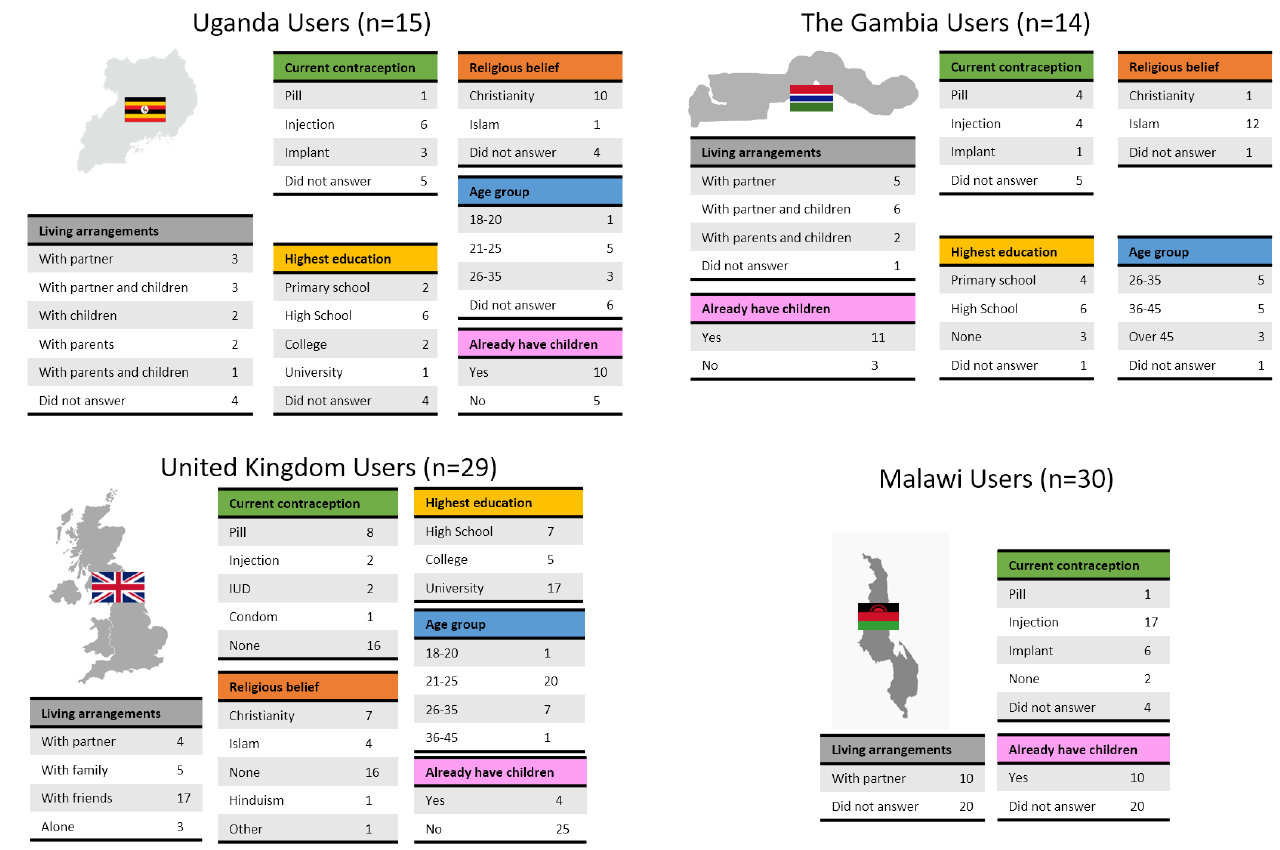
Figure 4. Demographic data of end users grouped by country. To receive comprehensive and diverse feedback, potential users of different age, education, religion, and at different stages of family planning were included in the